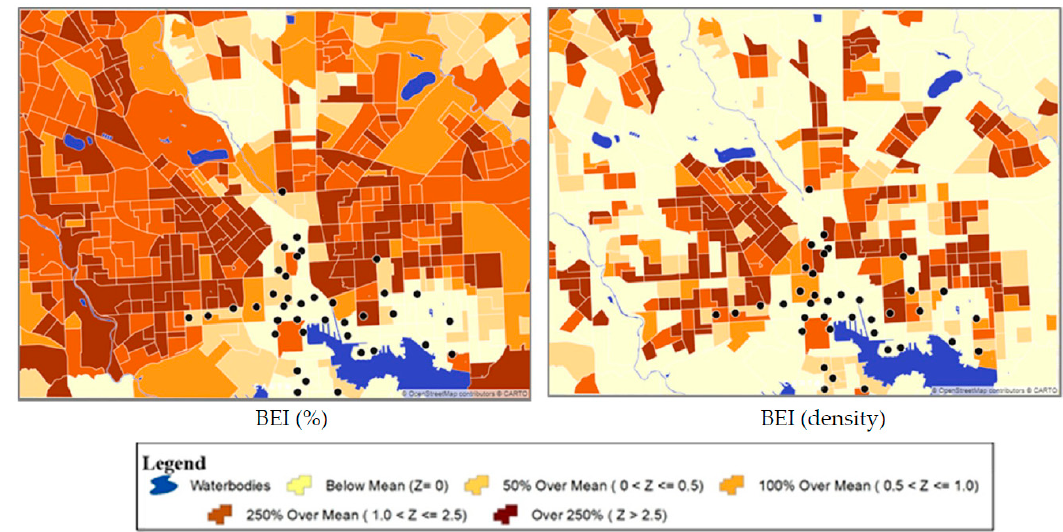
Figure 4. Bike Equity Index comparison.